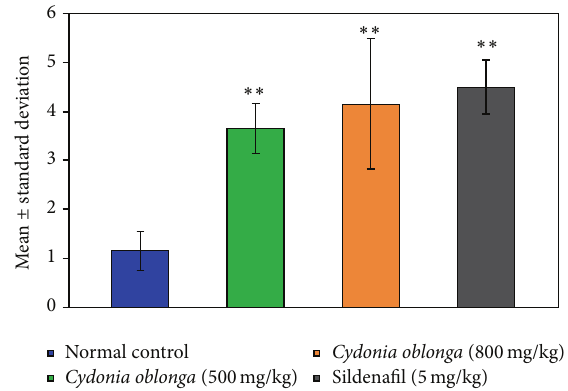
Figure 1: Effect of Cydonia oblonga on the mating performance of male rats on the 14th day of the